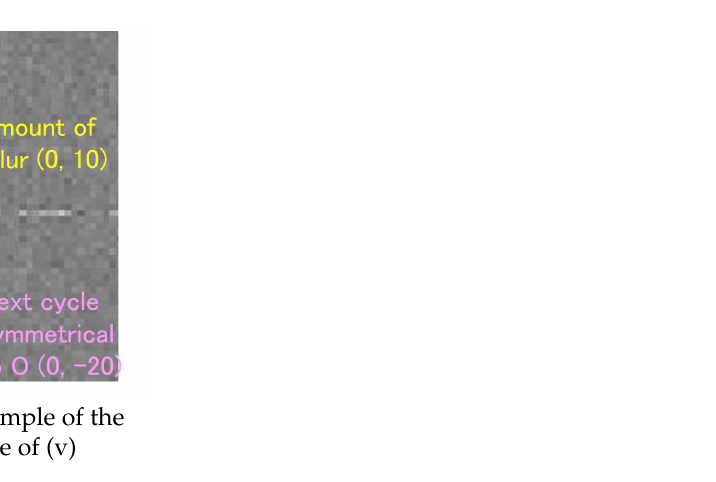
Figure 6. Examples of com-degraded image(10 pixels, 90 degrees) and cepstrum image from area A to D (121 × 121 pixels). Table 5. The blur amount (9 pixels, 26 degrees).